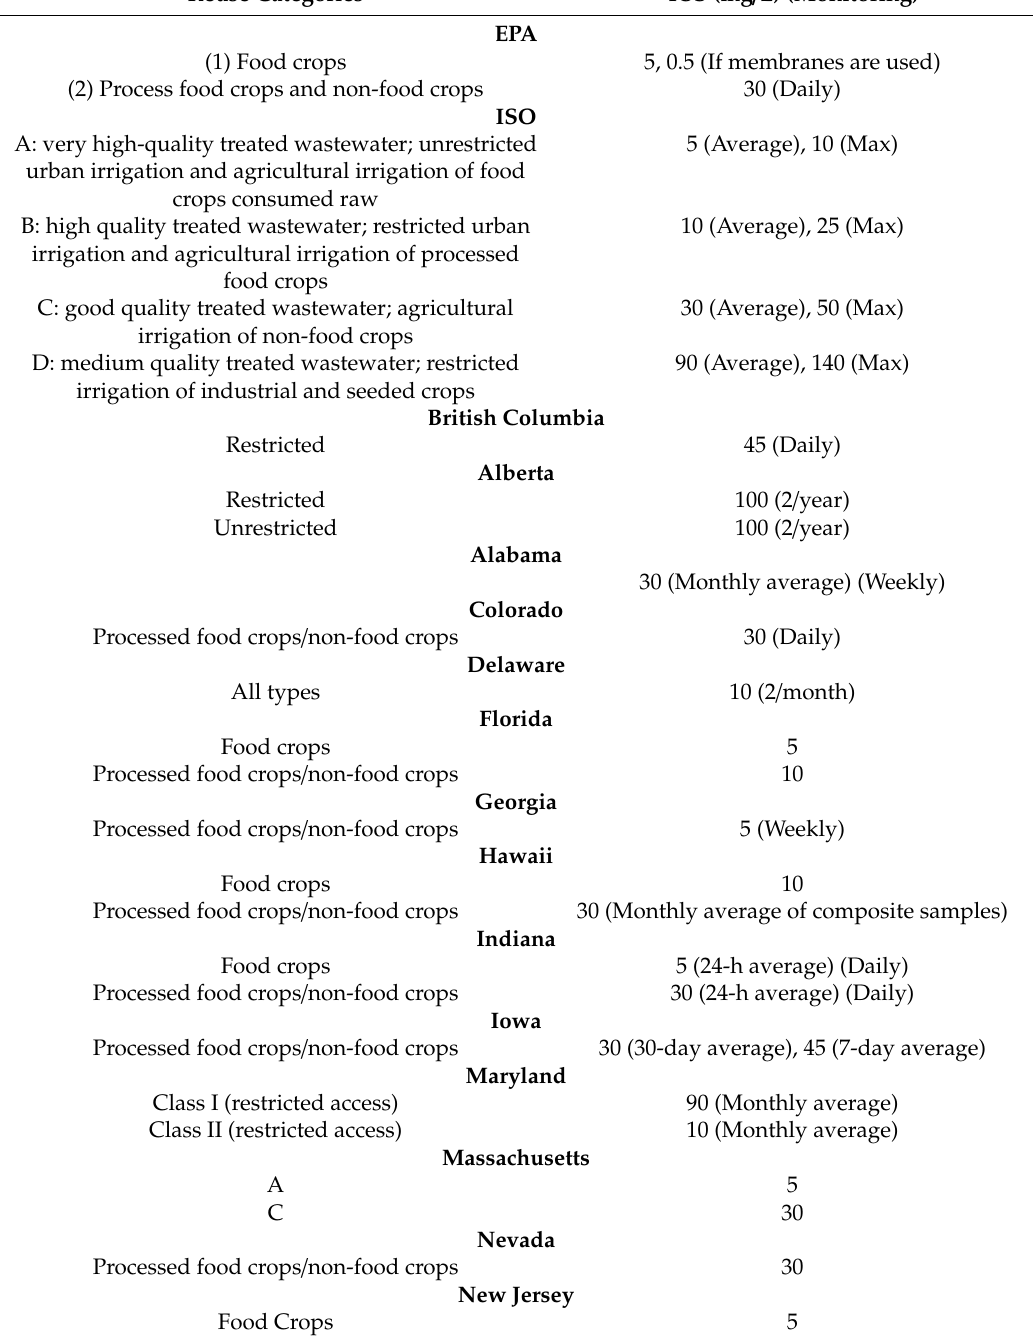
Table 16. TSS / SS thresholds in agricultural water reuse regulations and